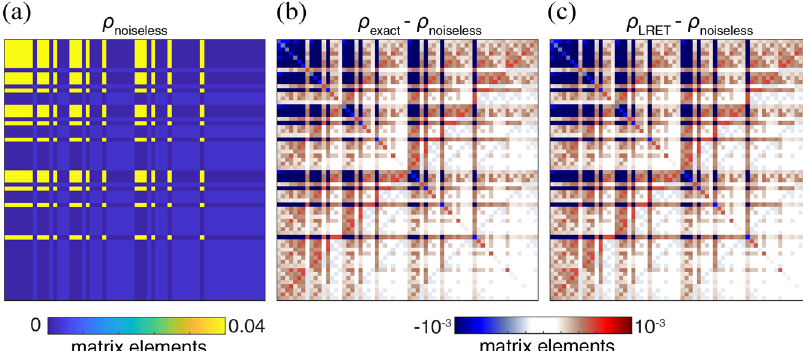
Fig. 1 An example of the low-rank method simulating noise with negligible error. a Density matrix from noiseless simulation, ρ noiseless . b Difference of density matrices from an exact noise simulation and from a noiseless simulation, ρ exact − ρ noiseless . c Difference of density matrices from a low-rank noise simulation and from a noiseless simulation, ρ LRET − ρ noiseless where LRET, the focus of this article, is a low-rank method. The rank of ρ LRET is 20% of that of ρ exact , and corresponds to 2.2% of distortion (de fi ned in “ Implementation and benchmarking “ ). The noise strength is p ≃ 0.33% and the truncation threshold is ϵ = 3 × 10 − 4